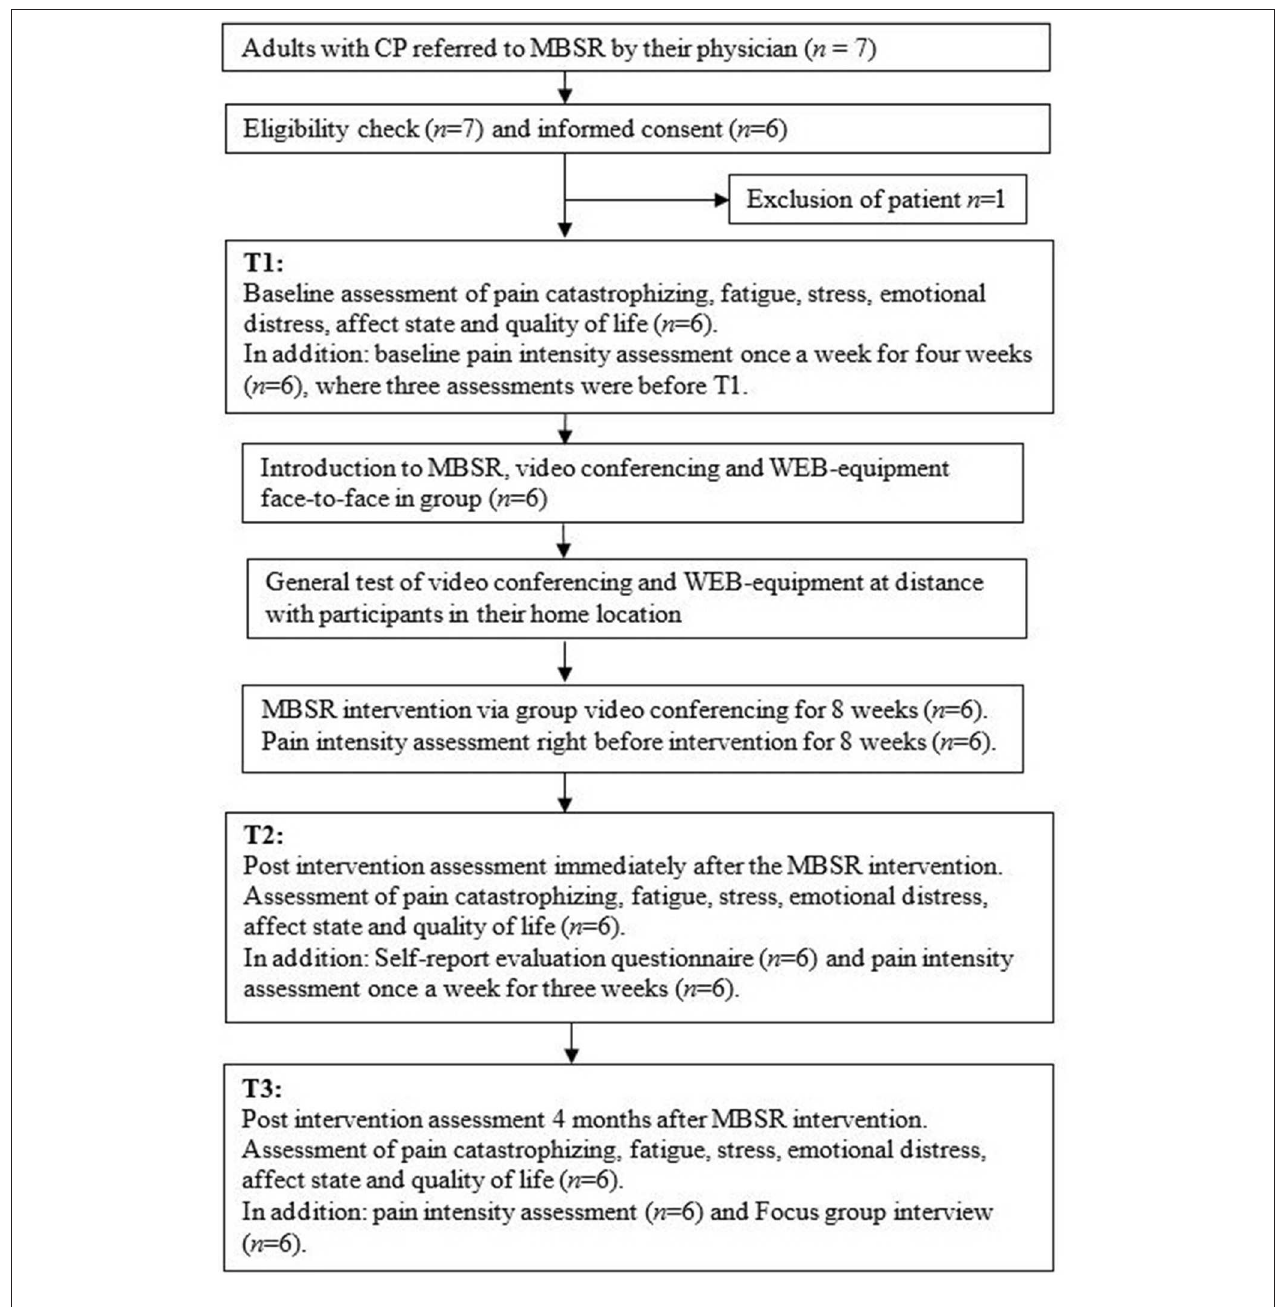
FIGURE 1 | Flow-chart for logistics during the study